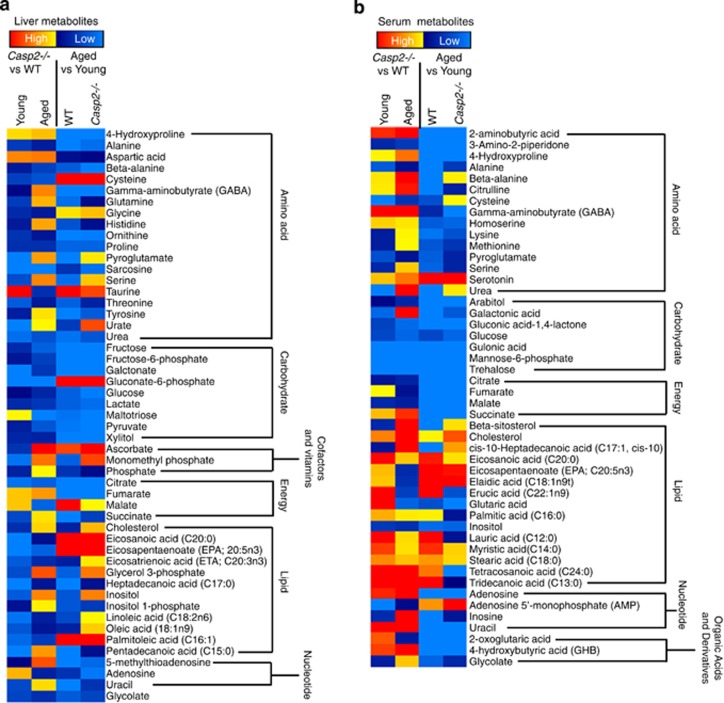
Differential liver and serum metabolome profiles of WT and Casp2−/− mice during ageing. (a and b) Heat maps of metabolites that are differentially altered in the (a) liver and (b) serum during ageing of WT and Casp2−/− mice and between genotypes within each age group. Heat map columns represent the average abundance of metabolites (n=6–8/group). (c) Example of some liver and serum metabolites that are significantly altered in abundance. (d) FFA and triglyceride levels in the liver and serum of young and aged WT and Casp2−/− mice. (e) Pyridine nucleotide (NAD+, NADH, NADP+, NADPH) levels in young and aged WT and Casp2−/− mice. Red-coloured boxes represented WT samples, and blue-coloured boxes represent Casp2−/− samples. Values are expressed as means±S.D. or as box-and-whisker plots, with values on top and at the bottom of the box representing 75th and 25th percentile and bar ‘whiskers' indicating the 10th and 90th percentile. *P<0.05, **P<0.01 (n=6–8/group). Individual values can be found in Supplementary Table S3. See Supplementary Figure S2